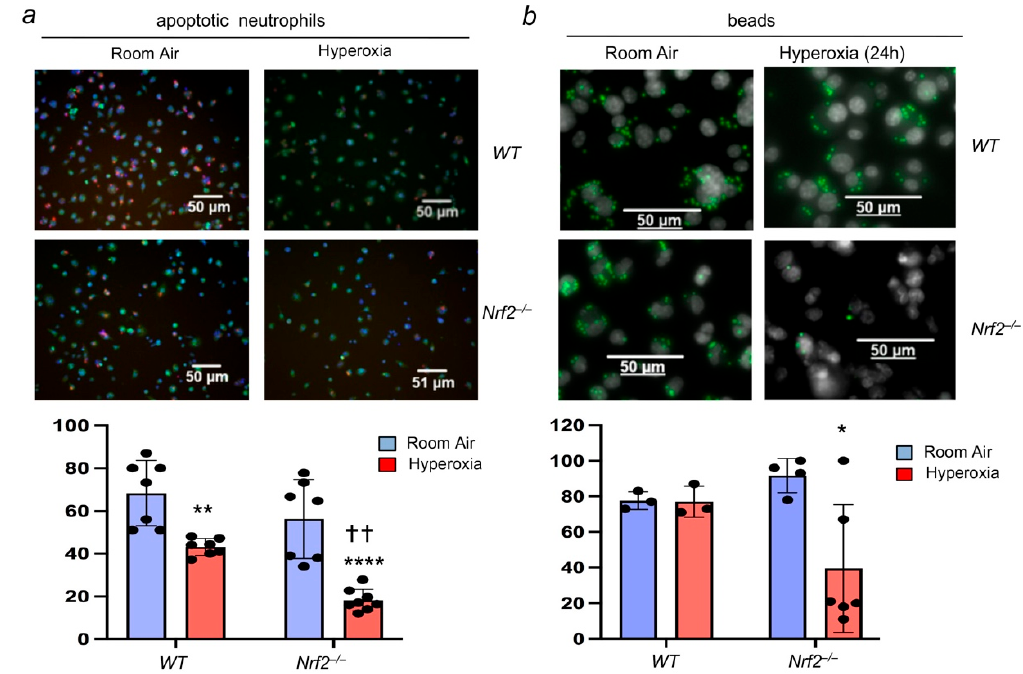
Figure 2. Nrf2 is required for optimal macrophage-mediated efferocytosis. BMDM φ s from Nrf2 +/+ (WT) and Nrf2 − / − mice were cultured and exposed to hyperoxia for 24 h. ( a ) Macrophages (green) were then incubated with labeled apoptotic neutrophils (red) for 1 h, washed, and captured images. ( b ) Macrophages were incubated with green fluorescent beads. Representative images of macrophages with neutrophils or beads for each genotype and experimental condition are shown. Values represent from at least three independent samples. * Room air versus hyperoxia of respective genotypes, †, Nrf2 − / − versus WT counterparts. * p < 0.05; **/†† p < 0.01; **** p < 0.0001. Blue, room air group; Red, hyperoxia group.